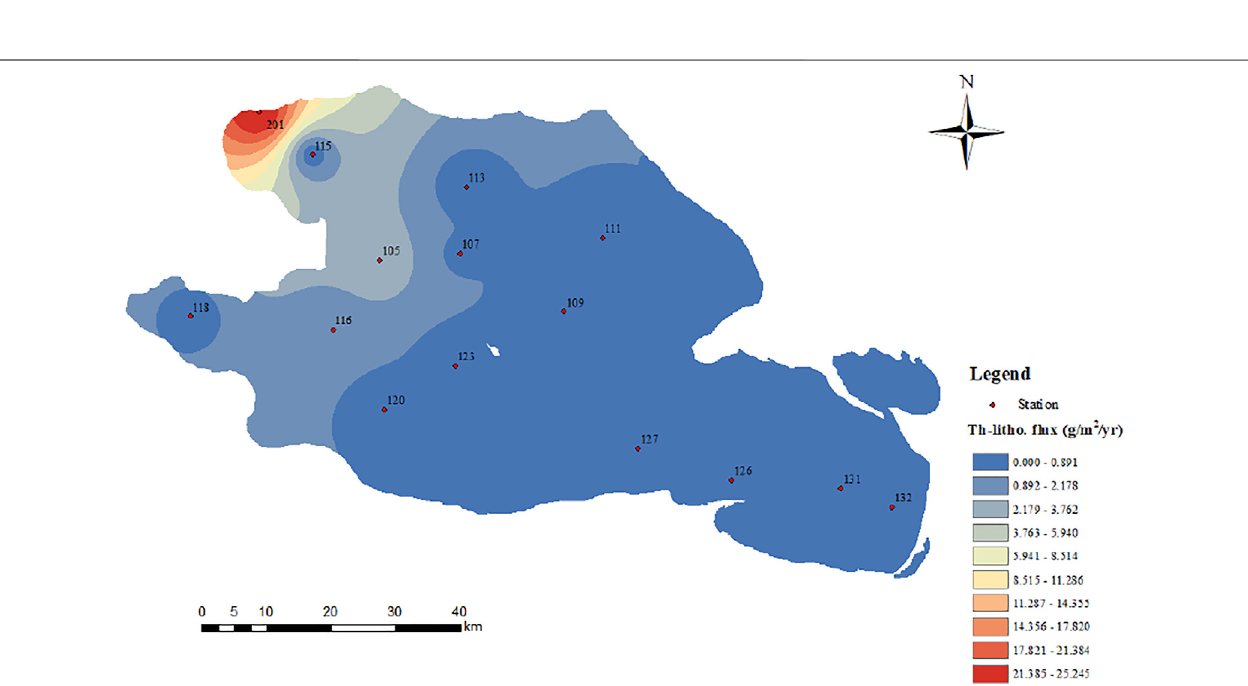
FIGURE 4 | Distribution characteristics of lithogenic fl ux in the surface water of Qinghai Lake.